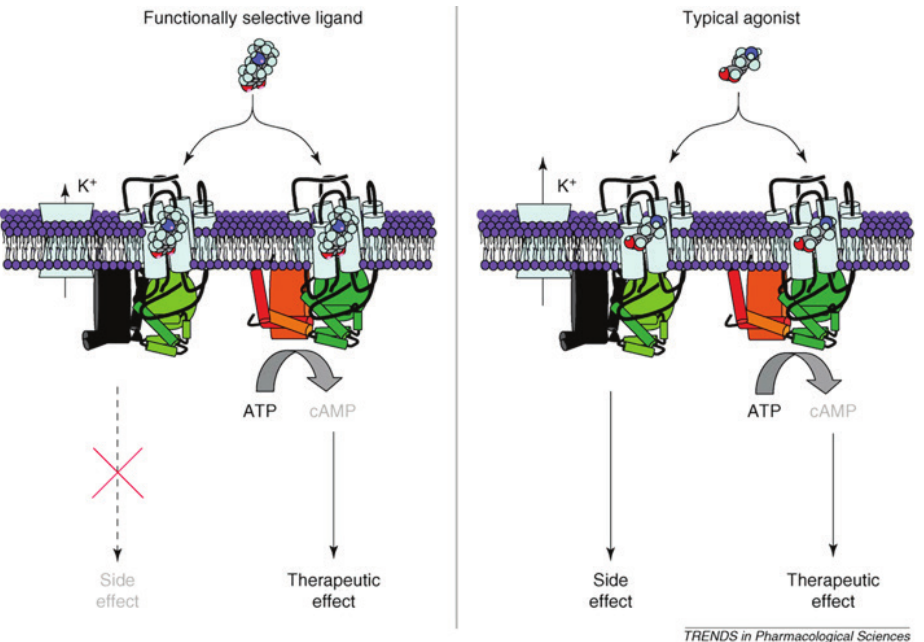
Figure 1: A scheme on functional selectivity based on differential agonist bias. Taken from (13)(fig. 2), with